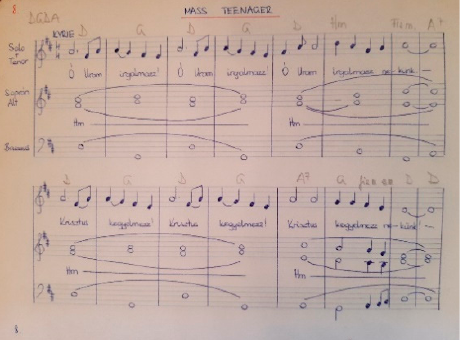
Figure 4. Handwritten sheet music from the 1970s. (Source: the author’s personal collection).